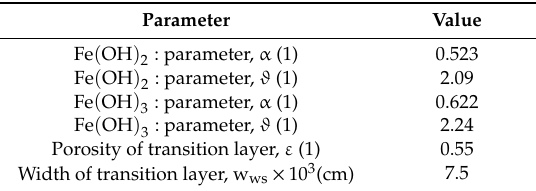
Table 4. Required parameters needed to determine the composition of corrosion products and the microstructure of the transition